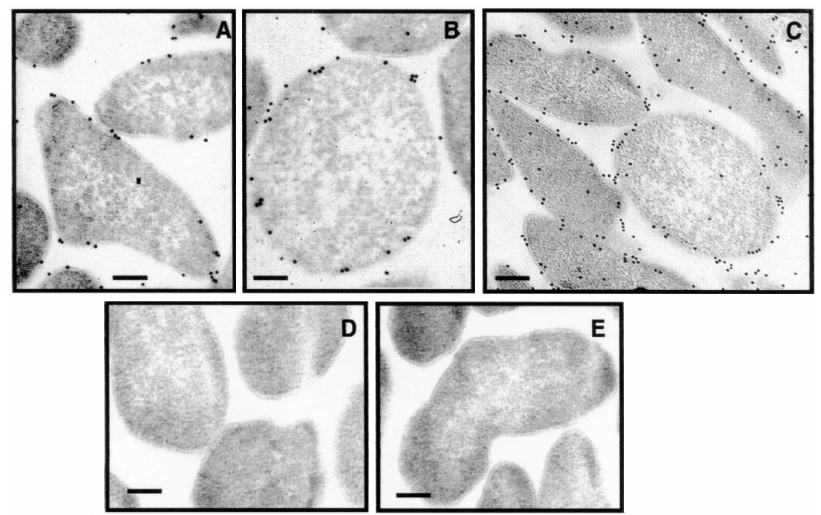
Figure 2. D -Lactate dehydrogenase is associated with the membrane. Ultra- thin sections (80–200 nm) shown in A, B and C were treated with anti-Dld an- tibody and secondary anti-chicken anti- bodies conjugated with 18-nm gold particles. Sections in D and E were in- cubated only with anti-chicken anti- body conjugated to 18-nm gold particles. Photographs were taken with a JEOL transmission electron micro- scope. Bar = 200 nm.